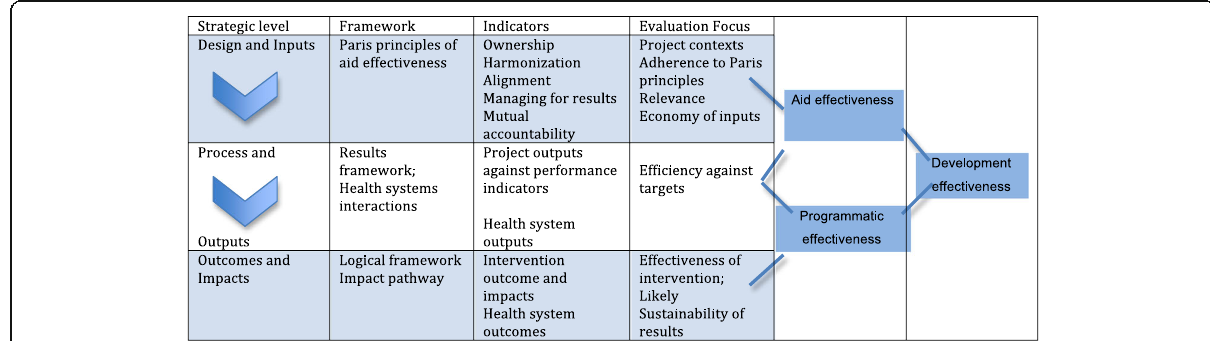
Fig. 1 Theoretical framework for aid effectiveness evaluation. Source: